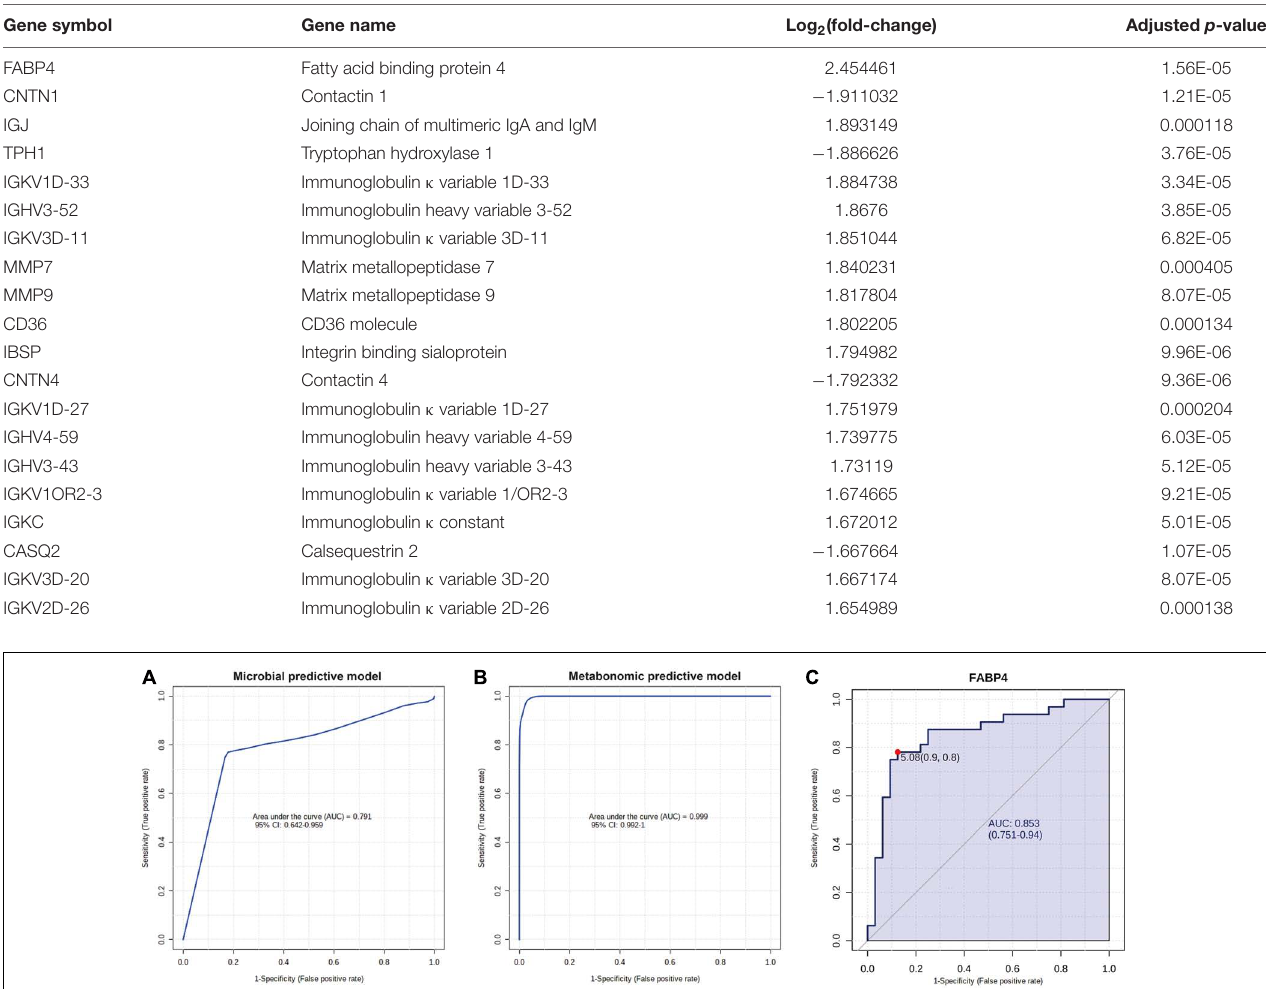
TABLE 4 | DEGs with top-20 | log 2 (fold-change)|.